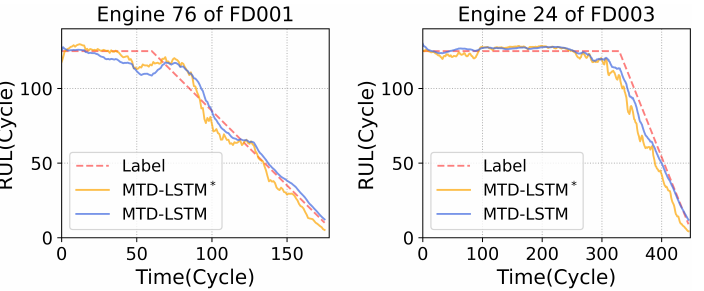
Figure 6. Comparison of prediction results of MTD-LSTM ∗ and MTD-LSTM on FD001 and FD003 under missing rate 0. Table 4. The FI comparison on FD003 under different missing rates. Missing